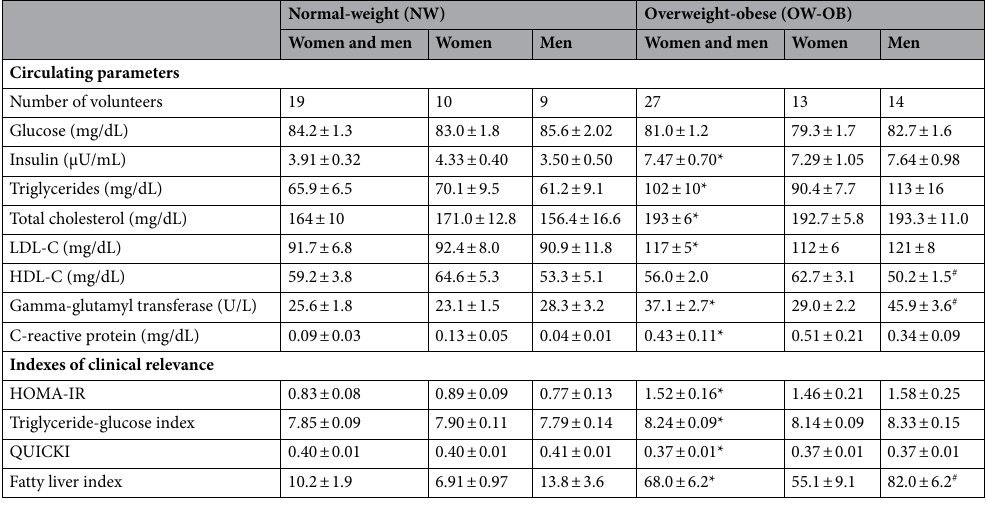
Table 2. Circulating parameters and indexes of clinical relevance in NW and OW-OB groups. Data in each group (NW and OW-OB) is analysed considering all the individuals (women and men together), and stratified by sex. Data are mean ± SEM (n = 20 in the NW and n = 27 in the OW-OB group). Statistics: *OW-OB vs NW, and # NW men vs NW woman and OW-OB men vs OW-OB woman, p < 0.05, Student’s t test. Data of circulating parameters in the NW group correspond to 19 subjects because of missing data of one